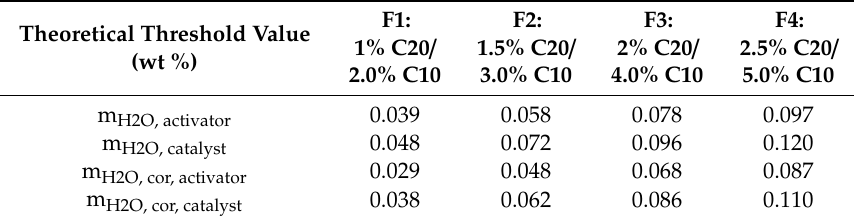
Table 1. Theoretical threshold value of water amount for elimination of reactive molecules of formulation